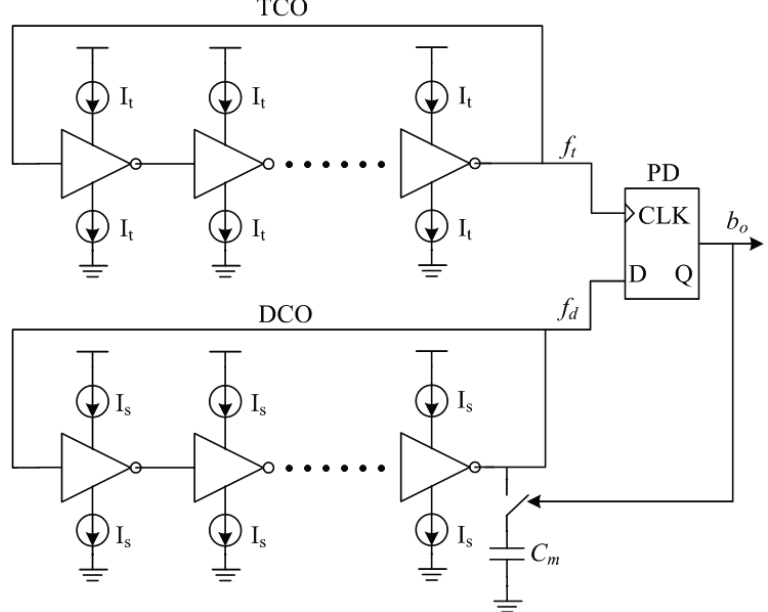
Figure 2. Proposed temperature sensor